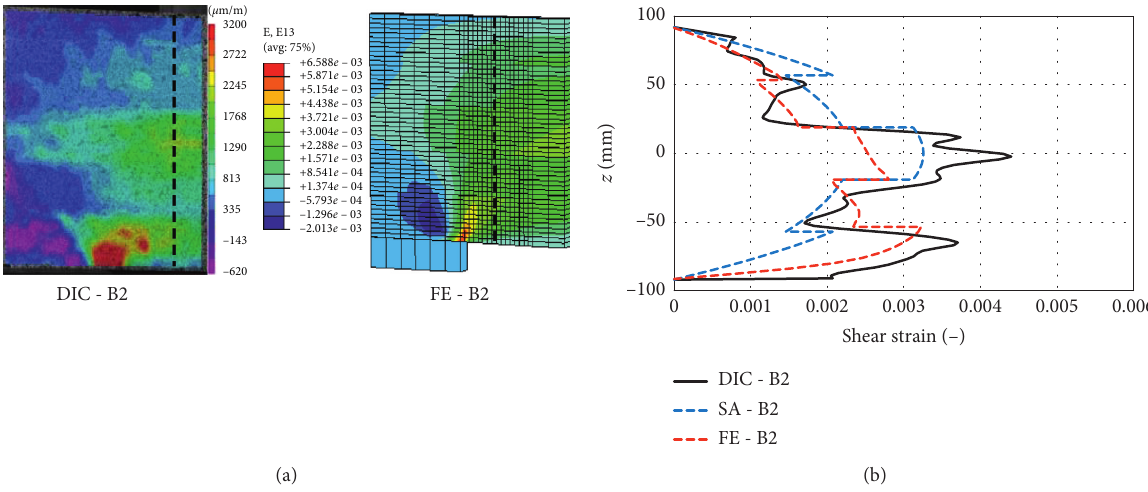
Figure 7: Colour contour plots and shear strain distribution from shear tests for